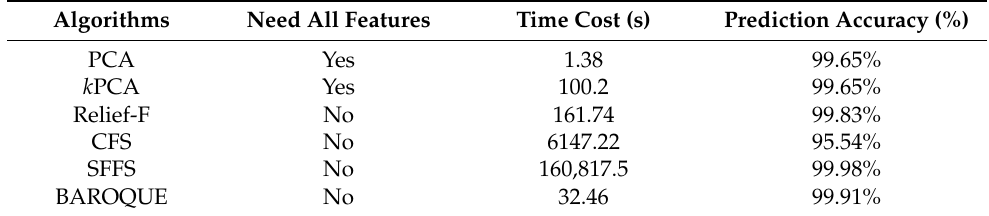
Table 4. Performance comparison among different feature selection